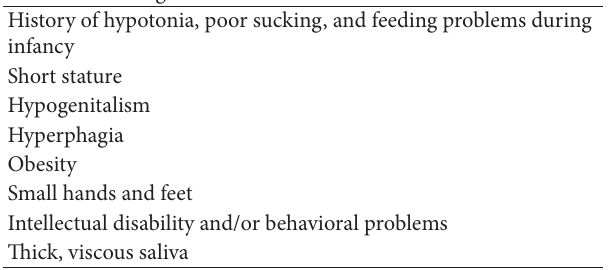
Table 1: Clinical features and common medical problems in adult PWS